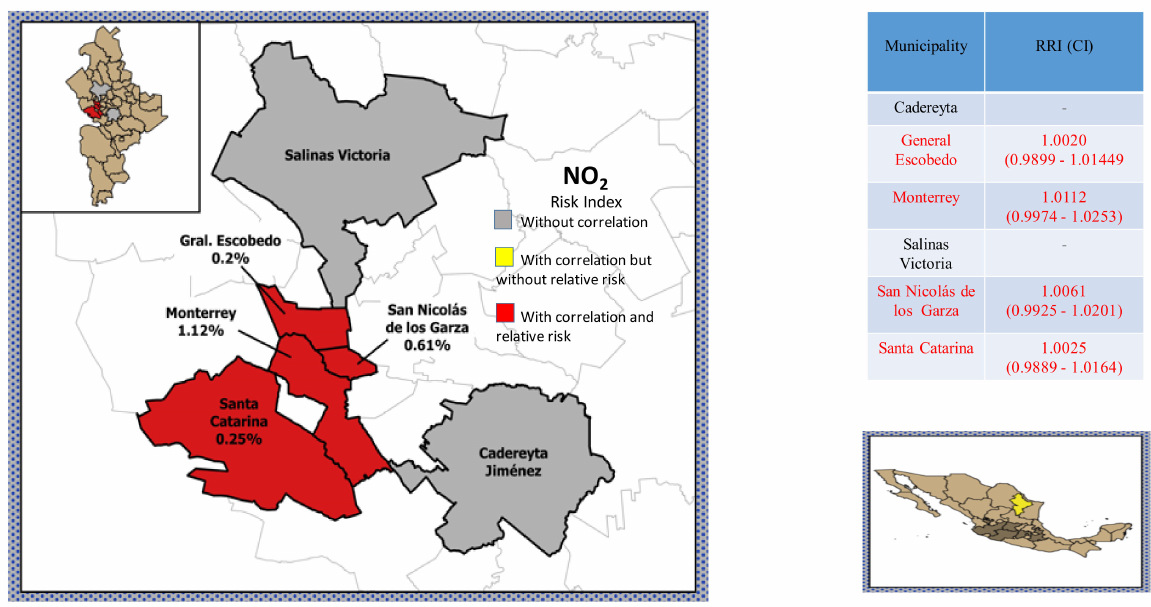
Figure 10. Relative risk indexes in MAM for the hypothetical scenario in which daily mean concentrations for NO 2 increased by 10%, considering all